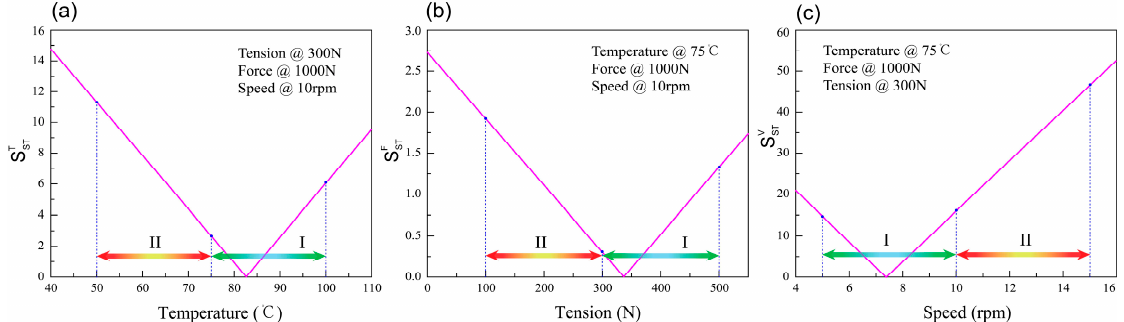
Figure 11. Single-parameter sensitivity curves for process parameters of the tensile strength model.